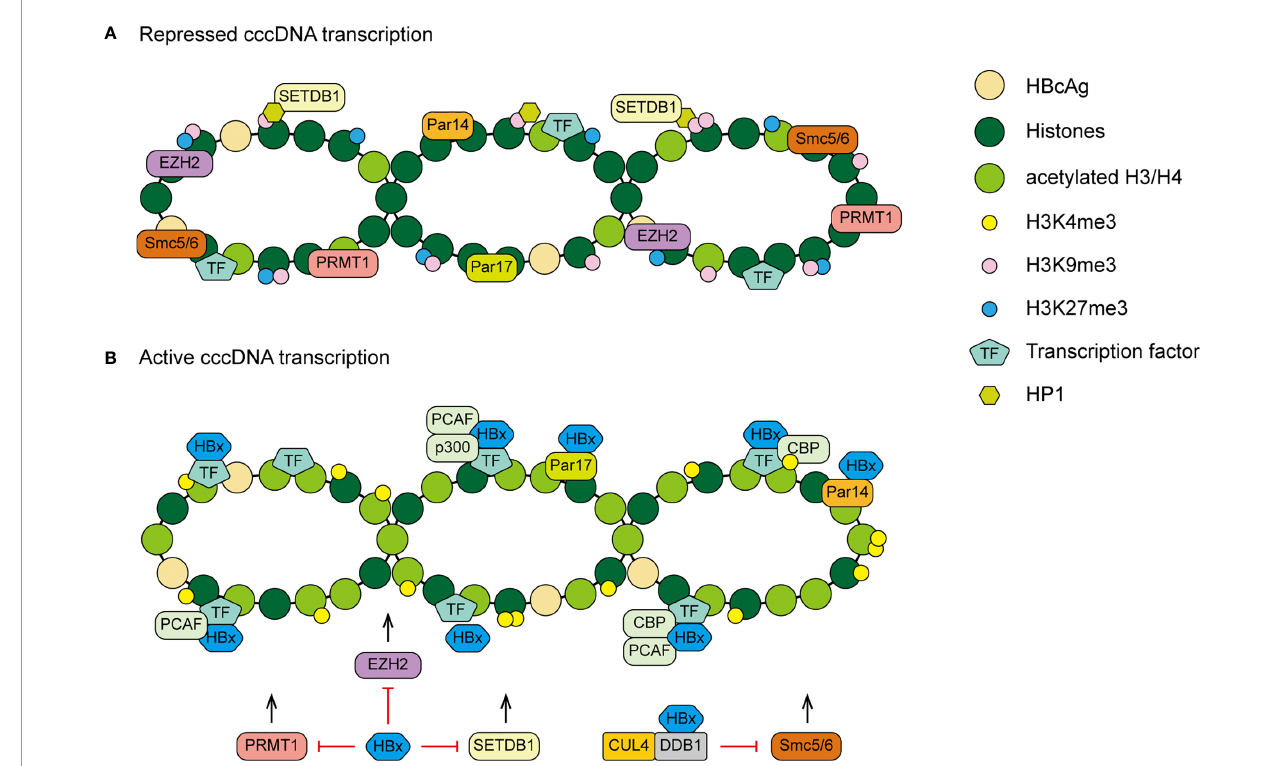
FIGURE 3 | A proposed model of HBx mediated cccDNA minichromosome epigenetic modulation. (A) In the absence of HBx, cccDNA-bound histones are hypoacetylated and the host restriction factors are recruited on the cccDNA, contributing to repressed gene transcription and viral replication. (B) In the presence of HBx, HATs are recruited to cccDNA and host restriction factors, such as PRMT1, EZH2, SETDB1 and Smc5/6, are inhibited by HBx, leading to hyperacetylation of cccDNA-bound histones and active cccDNA